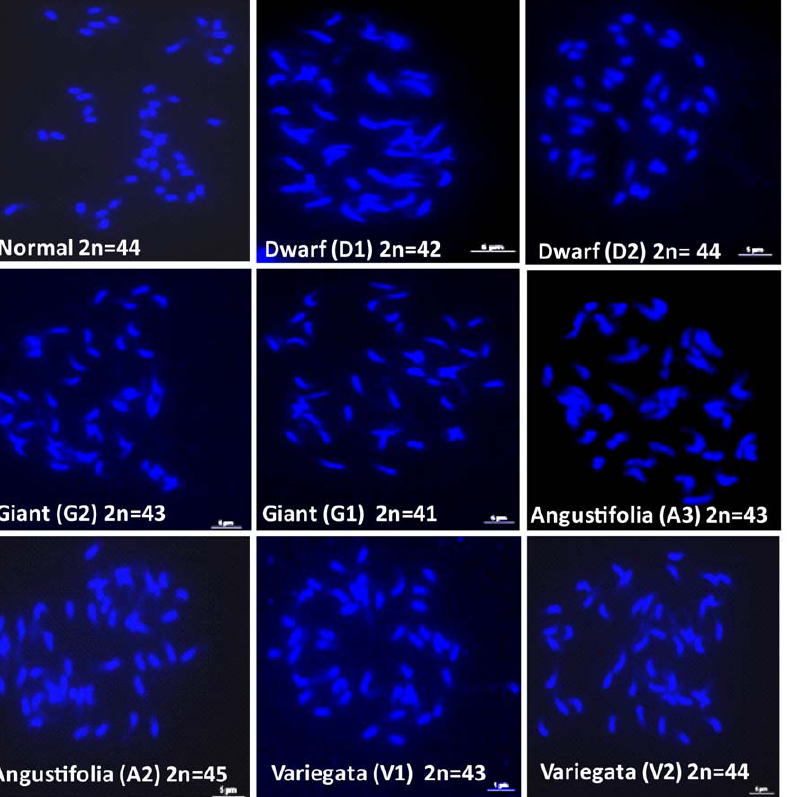
Figure 6. Mitotic cells at metaphase or prometaphase stages and observed ploidy levels of some normal and variant emblings from the allotetraploid C.arabica species (2n=44). Karyotype analyses were performed by counting chromosomes on four to eight clear metaphase spreads obtained from root tips of three year-old plants.